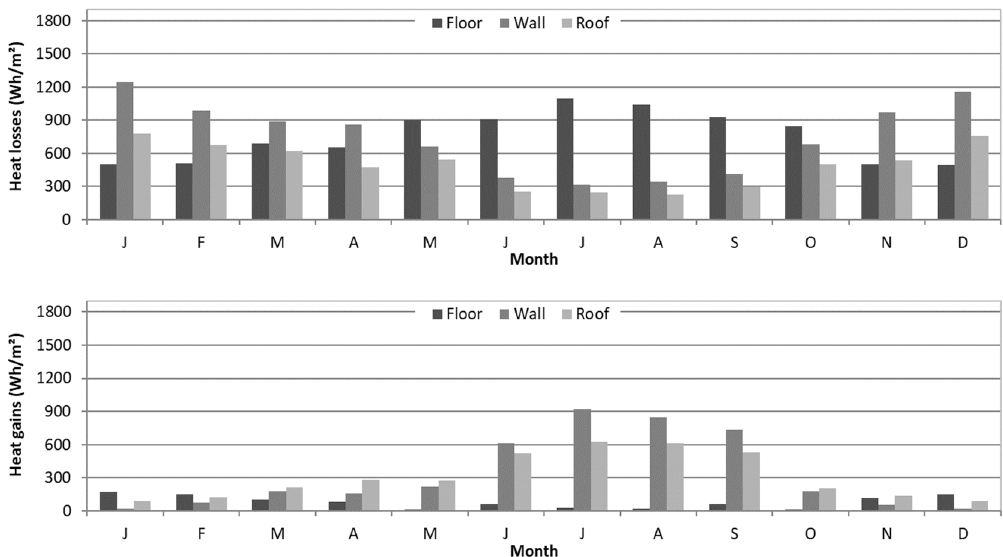
Figure 2. Energy losses-gains conduction heat transfer (envelope) throughout the year in Sevilla.